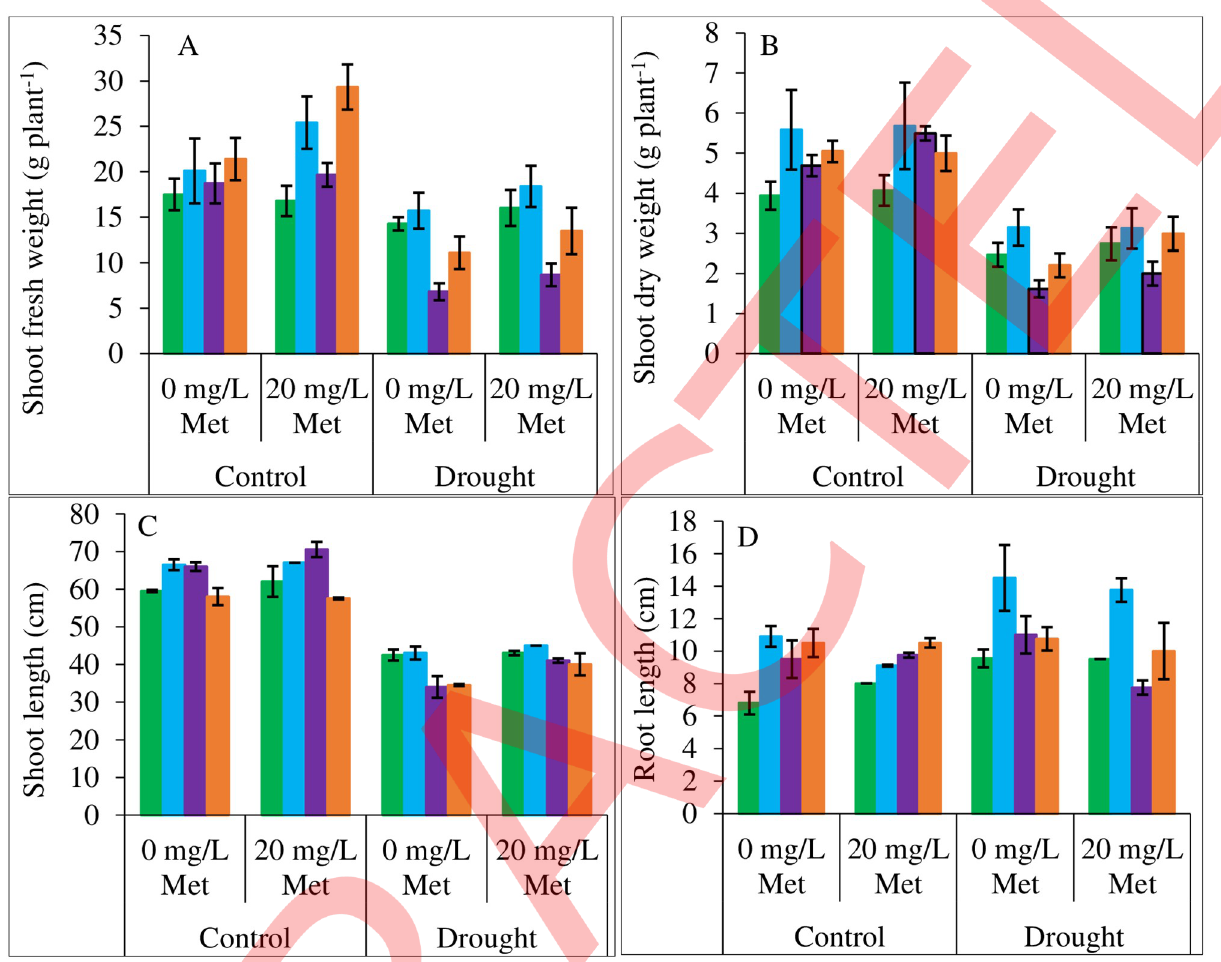
Fig 1. Effect of foliarly treated L-methionine on (A) Shoot fresh weight, (B) shoot dry weights, (C) shoot length and (D) root lengths in sunflower ( Helianthus annuus L.) plants grown under water deficit condition (Mean ± S.E.).